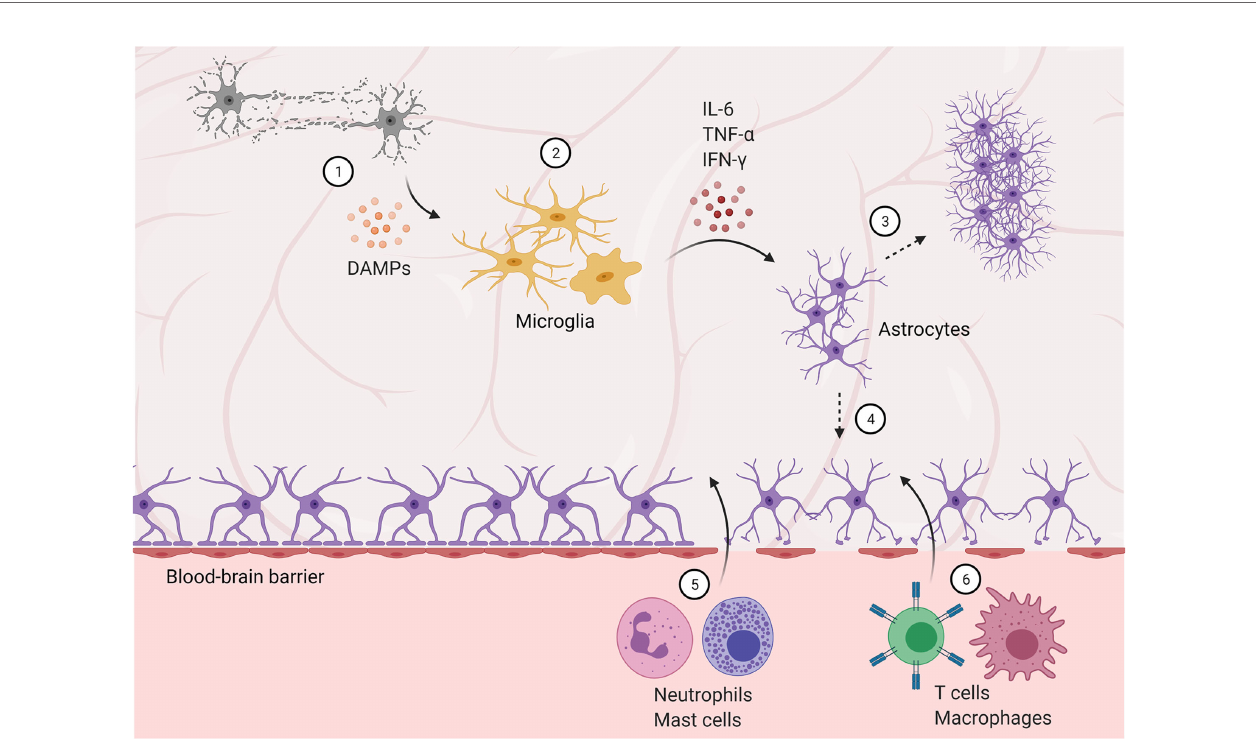
FIGURE 1 | Blood-brain barrier disruption allows peripheral immune cells to in fi ltrate the central nervous system. (1) Damaged and dying neurons secrete damage- associated molecular patterns (DAMPs), activating microglia. (2) Microglia are polarized to an M1, pro-in fl ammatory phenotype and secrete pro-in fl ammatory cytokines and factors, activating astrocytes. (3) Reactive astrocytes form a glial scar, temporarily protecting the brain but preventing future regeneration. (4) Astrocyte activation and dysfunction contributes to blood-brain barrier disruption, allowing in fi ltration of neutrophils and mast cells in the subacute phase (5), followed by T cells and peripheral macrophages (6) in later